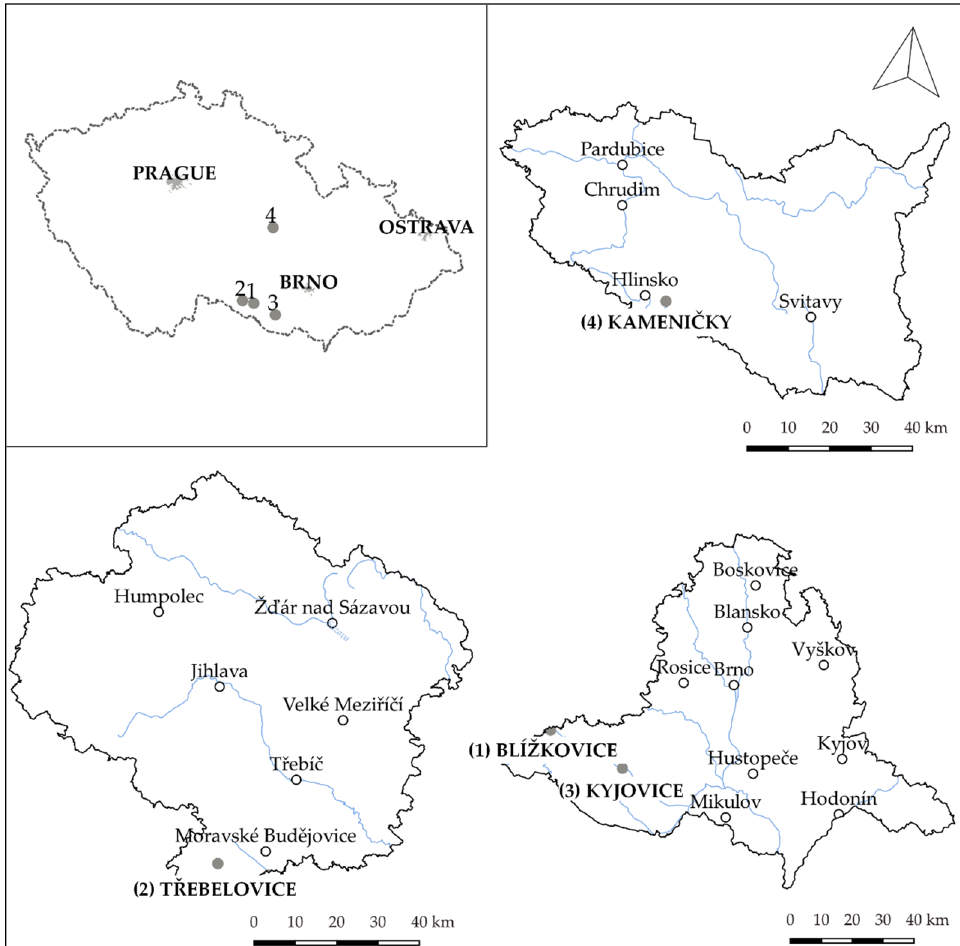
Figure 1. Localization of the four bosks within the Czech Republic.